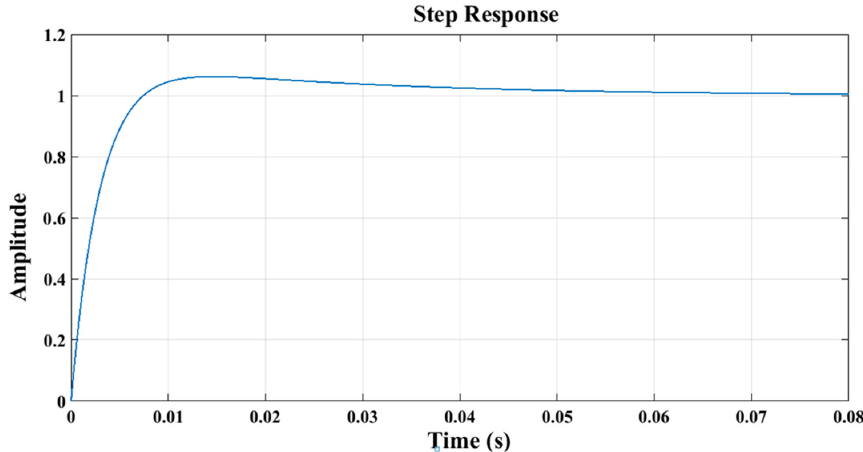
Figure 5. The process step response after regulation.